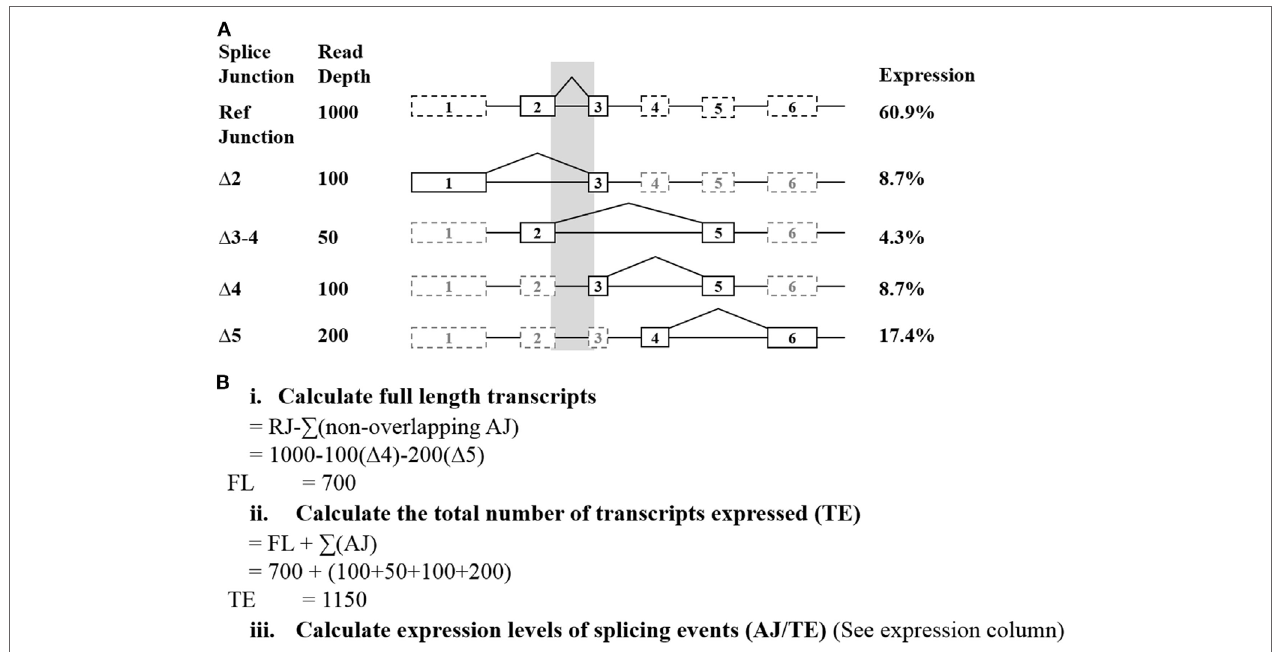
FigUre 1 | Exemplar of how the relative expression of each splice junction was calculated from targeted RNA-seq data. (a) The shaded region indicates the alternative splicing events excluded from the full-length calculations. Solid lines indicate the exons directly involved with an exon skipping event. (B) Calculations used to determine the relative expression of each detected junction. Abbreviations: AJ, alternate junction; RJ, reference